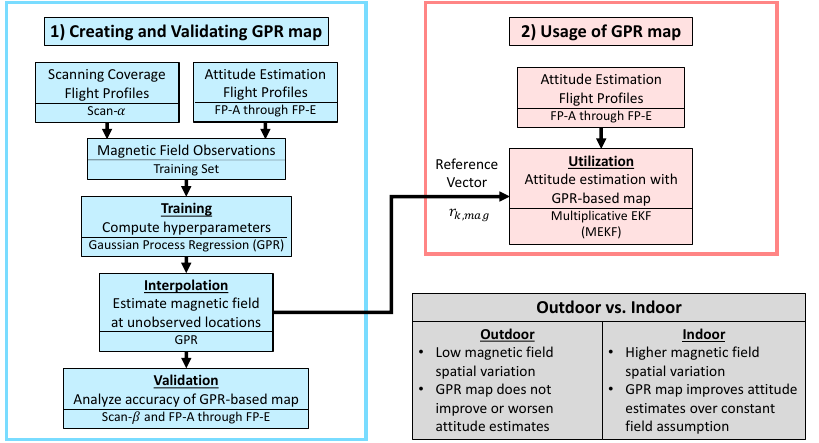
Figure 1. Outline of the main methods of this paper. Several flight profile (FP) trajectories are used to train, validate, and utilize a Gaussian process regression (GPR)-based